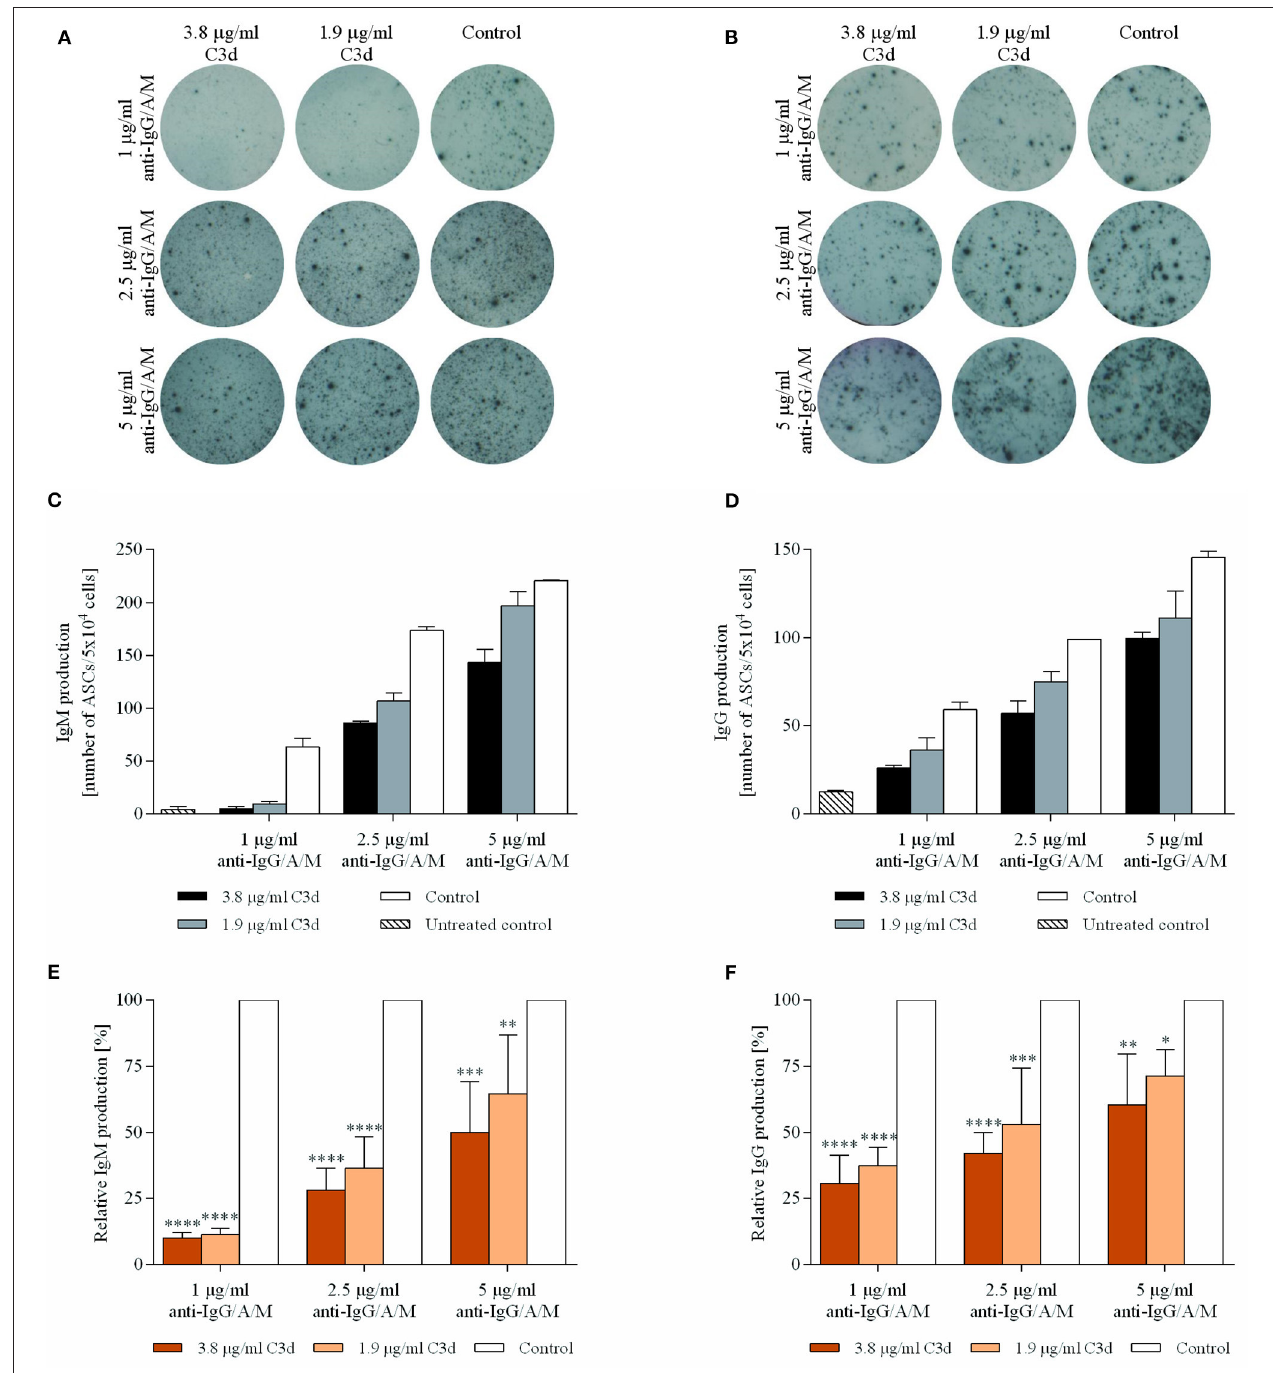
FIGURE 5 | Antibody production is inhibited by co-ligation of CR2 with the BCR. Resting human B cells were cultured with complexes consisting of either streptavidin-conjugated biotinylated anti-IgG/A/M (control) or streptavidin-linked biotinylated anti-IgG/A/M and biotinylated C3d in different concentrations as indicated, for 72h. IgM (A,C,E) and IgG (B,D,F) -antibody secreting cells (ASCs) were enumerated by enzyme-linked immunosorbent spot (ELISpot) assays. Images of representative membranes depicting the IgM (A) and IgG (B) producing B cells, and mean numbers of IgM (C) and IgG (D) secreting B cells ± SD of triplicate samples of a representative donor are shown. Quantity of IgM (E) and IgG (F) producing B cells was compared to the control samples taken as 100%. The cumulative results obtained in three independent experiments display the mean of the relative values ± SD. * p < 0.05, ** p < 0.01, *** p < 0.001, **** p < 0.0001.